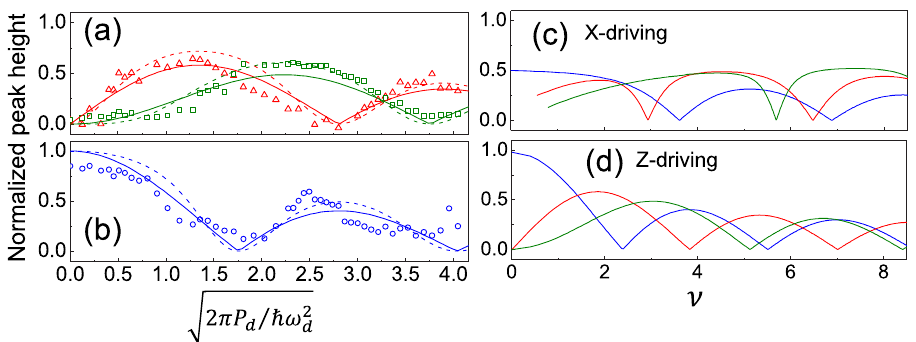
Figure 5. ( a ) and ( b ) Normalized peak height as a function of normalized driving microwave amplitude for 1 (blue), 2 (red) and 3 (green) processes. All data sets are normalized by identical parameters. The solid m = J m curves are while the dash curves show the results by Eq. (5). ( c ) and ( d ) The calculated transmission 1 | | − amplitudes as a function of driving amplitude ν for X-driving model ( c ) and Z-driving model ( d